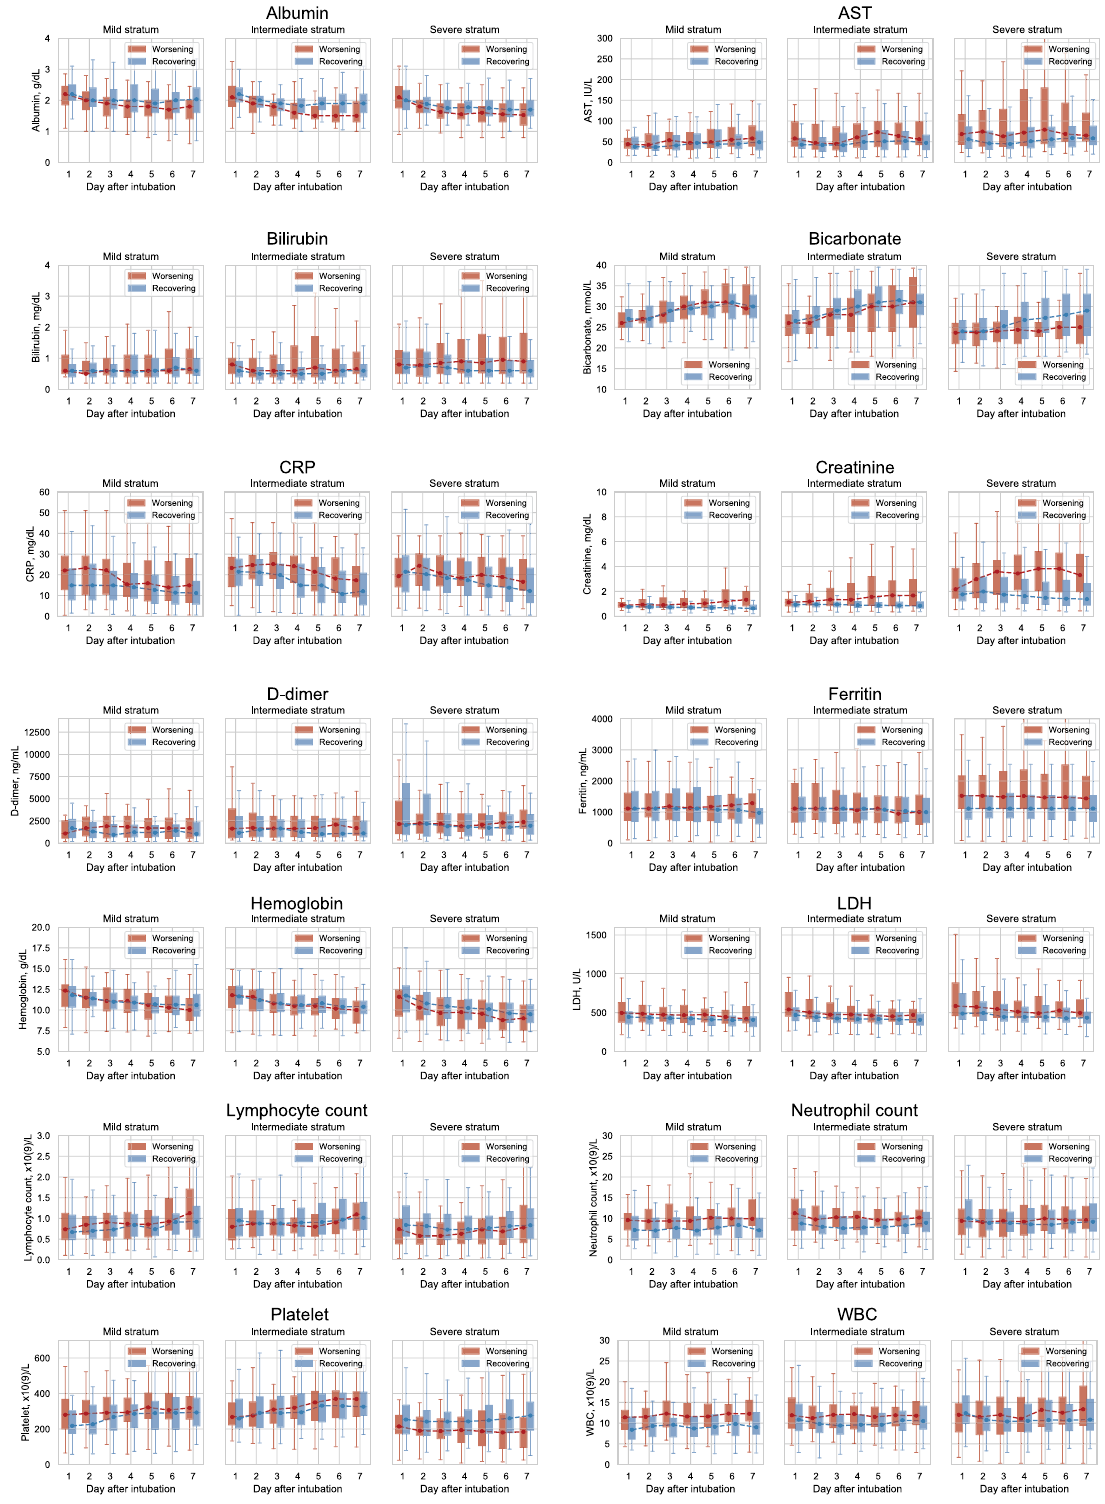
Figure 4. Laboratory test value trajectories of the identified subphenotypes. AST Aspartate aminotransferase, CK creatine kinase, CRP C-reactive protein, LDH lactate